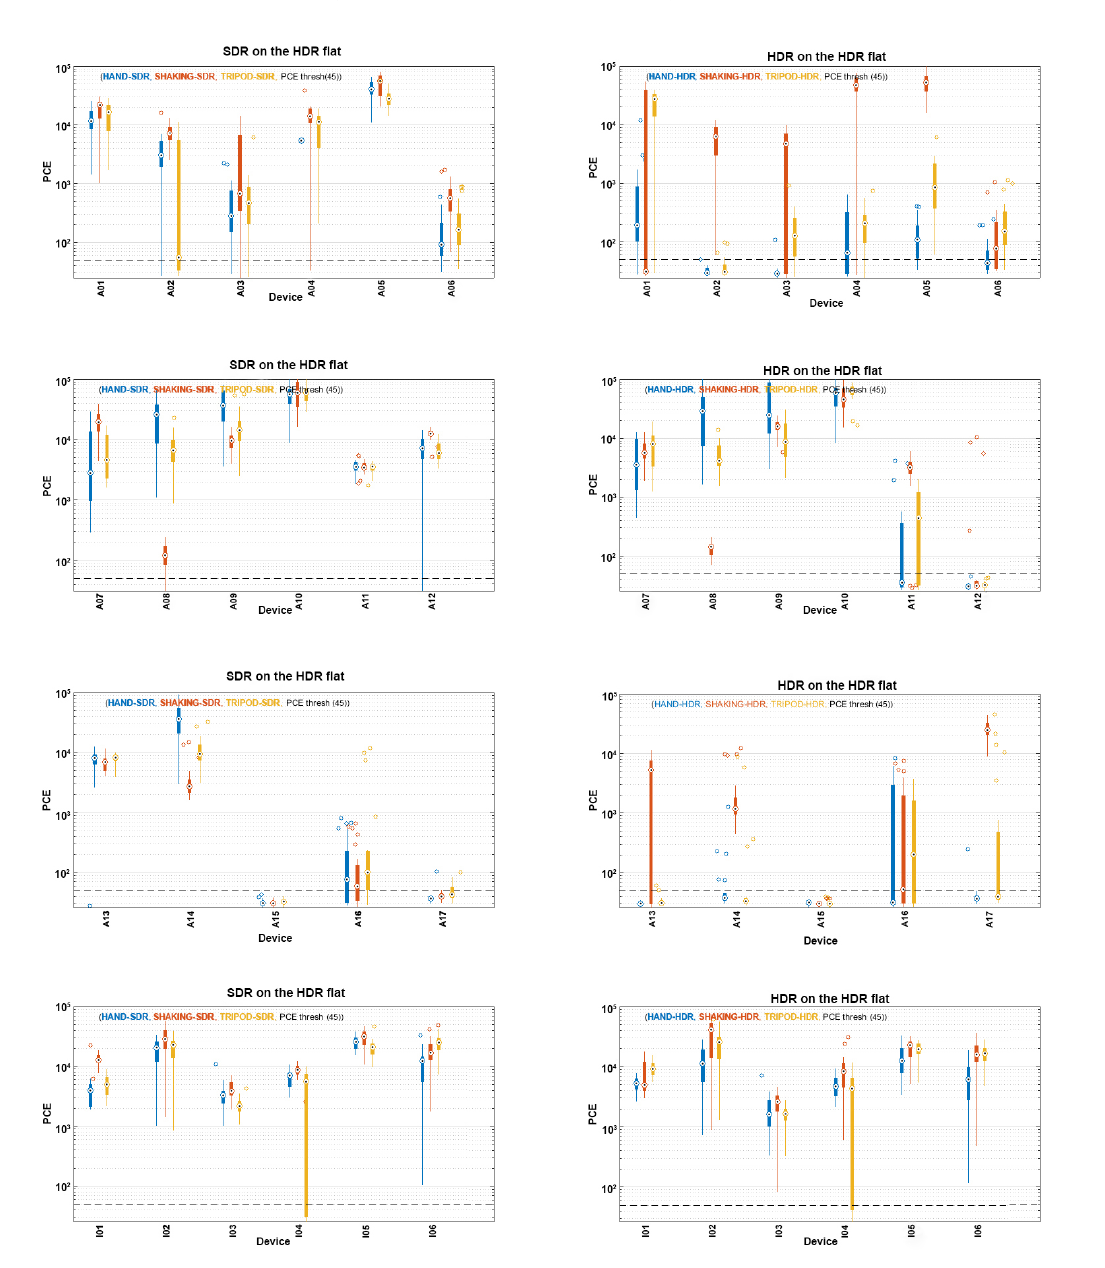
Figure 6. PCE values obtained by SDR and HDR images when compared with a flat HDR-based